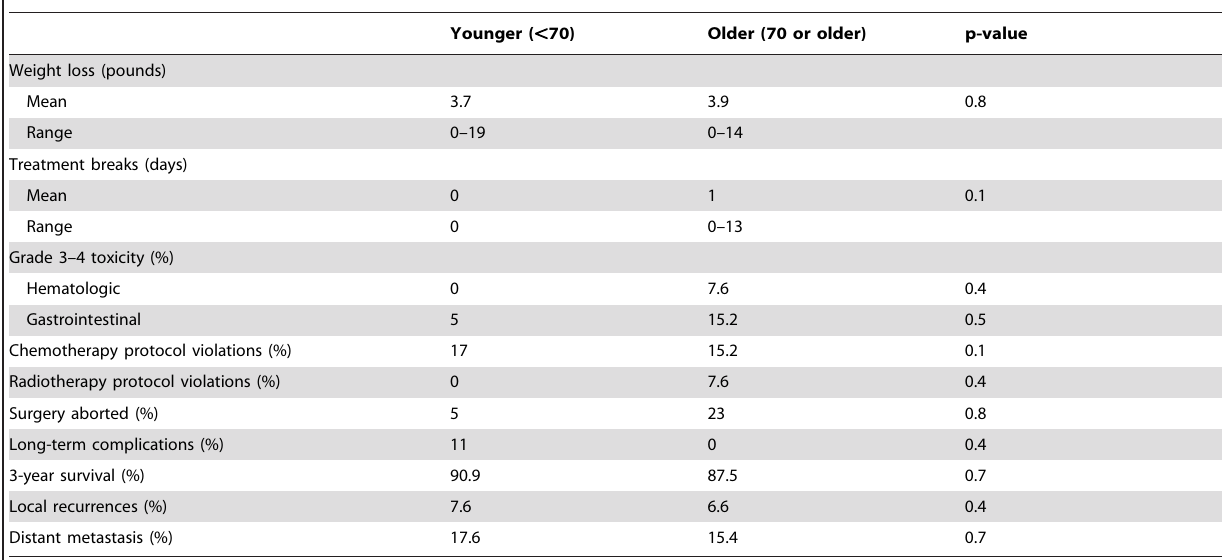
Table 2. Treatment toxicity and patient outcome.